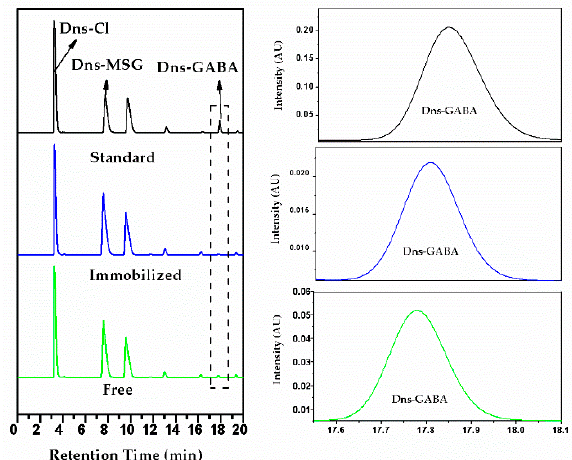
Figure 6. HPLC chromatogram for standard GABA, free and immobilized GAD with zoomed in GABA peaks.